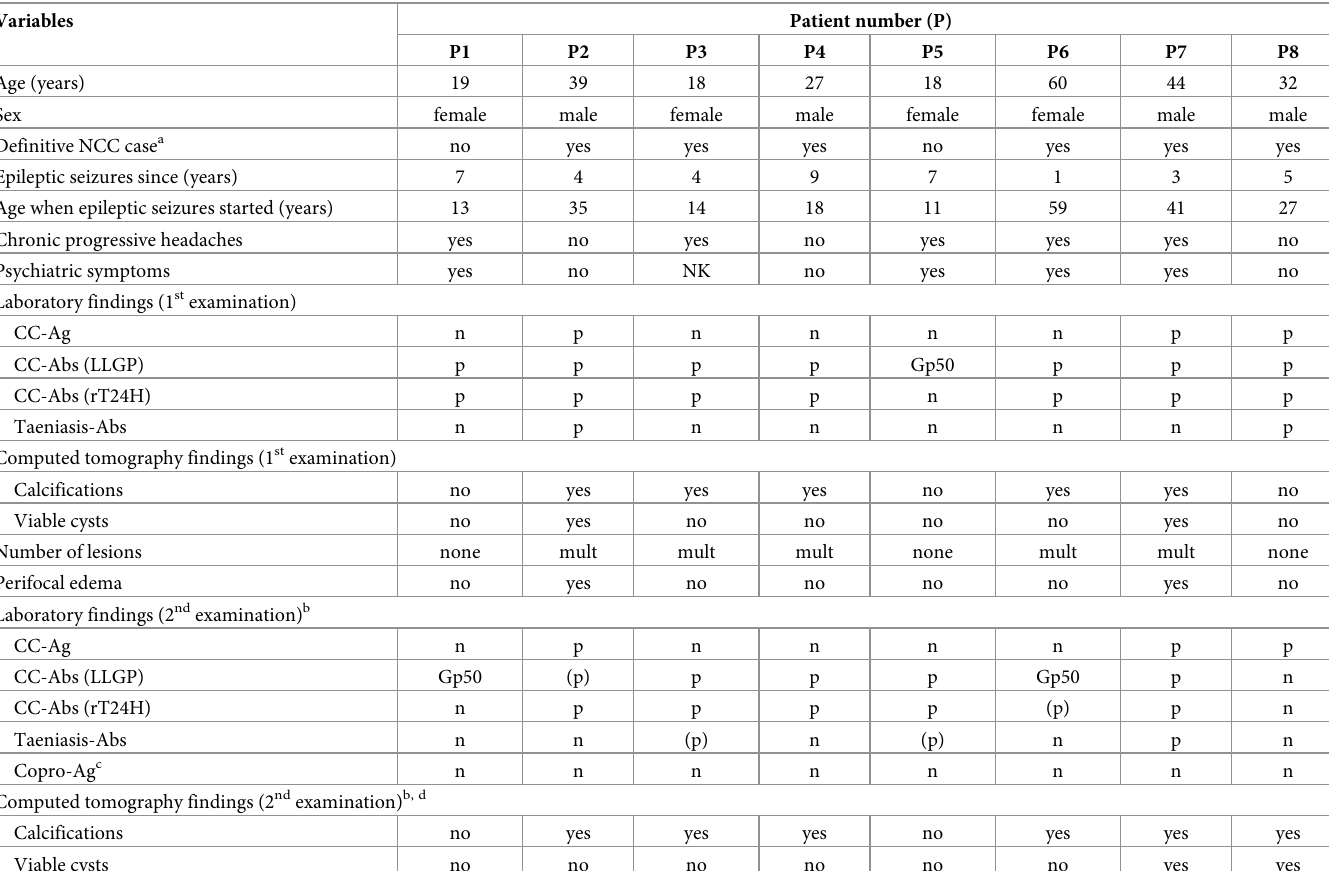
Table 3. Serological, neurological and radiological characteristics of people with epilepsy seropositive for T . solium cysticercosis and